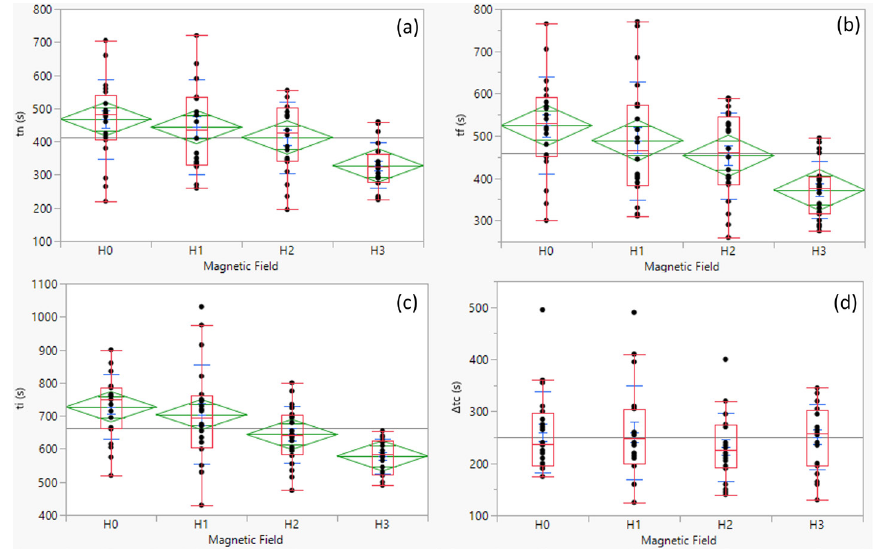
Figure 4. Individual data and statistical analysis of the time parameters for freezing of CoNHH as a function of the magnetic field intensities: (a) nucleation time ( t ), (b) freezing time ( t ), (c) inflection time ( t ), and (d) crystallisation period (Δ t n f i